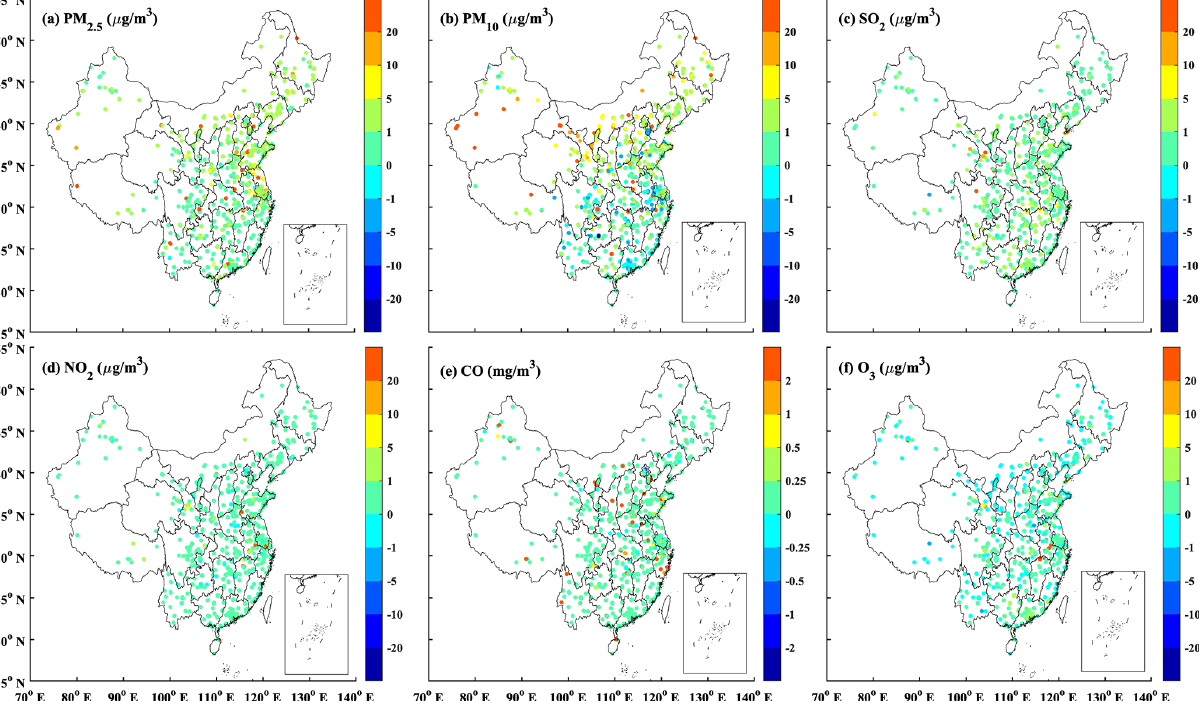
Figure A2. Spatial distributions of differences in annual concentrations of six air pollutants in China before and after quality control averaged from 2013 to